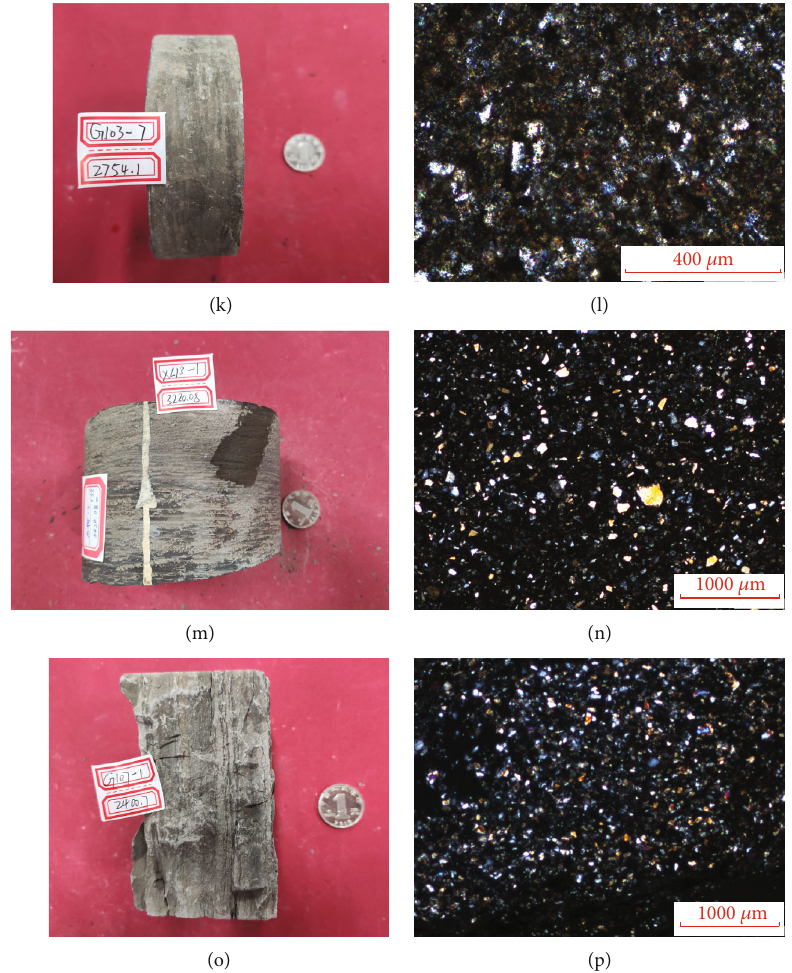
Figure 8: (a, b) Calcareous-rich MS, well XL25x, 3540.65m; (c, d) calcareous-rich MS, well G24, 2617.00m; (e, f) calcareous MS, well XL25x, 3538.41m; (g, h) clay MS, well B11x, 3543.90m; (i, j) clay MS, well G34, 2517.56m; (k, l) clay-rich MS, well G103, 2754.10m; (m, n) felsic MS, well XL13, 3220.08m; (o, p) felsic-rich MS, well G107,